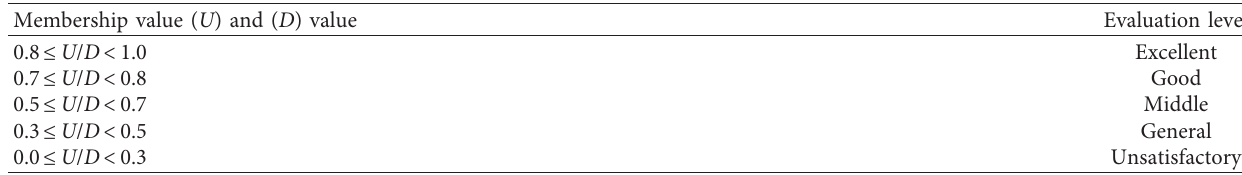
Table 9: Evaluation grade of membership value ( U ) and D value.